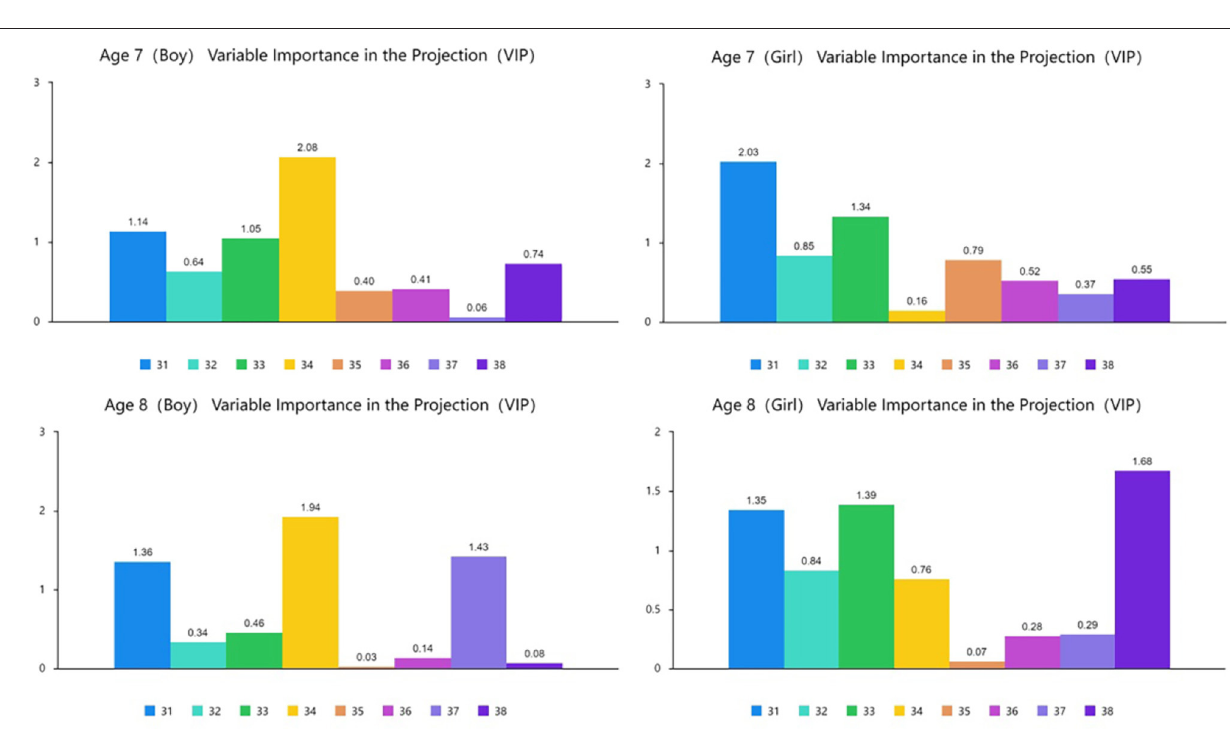
Frontiers in Public Health |